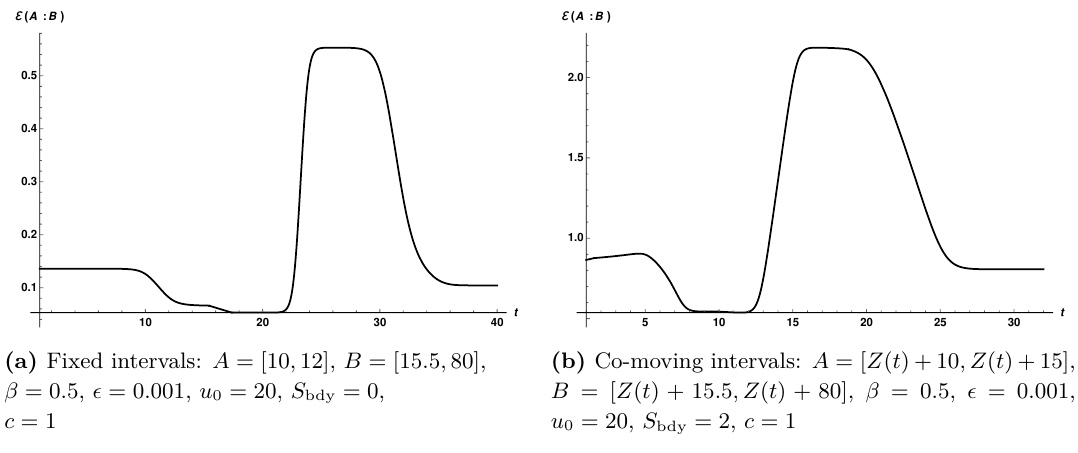
Figure 26. Disjoint intervals. Page curve for the entanglement negativity between two disjoint intervals in a kink mirror